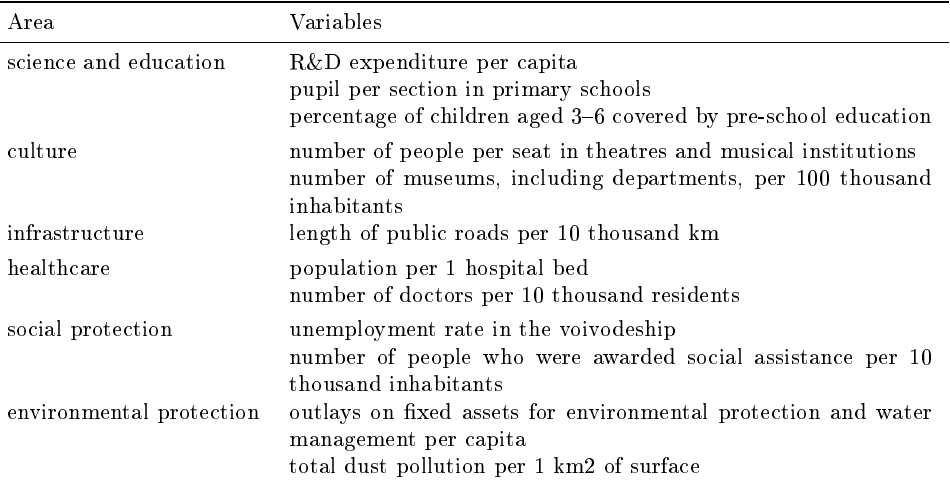
Table 2: List of areas with the variables adopted in the